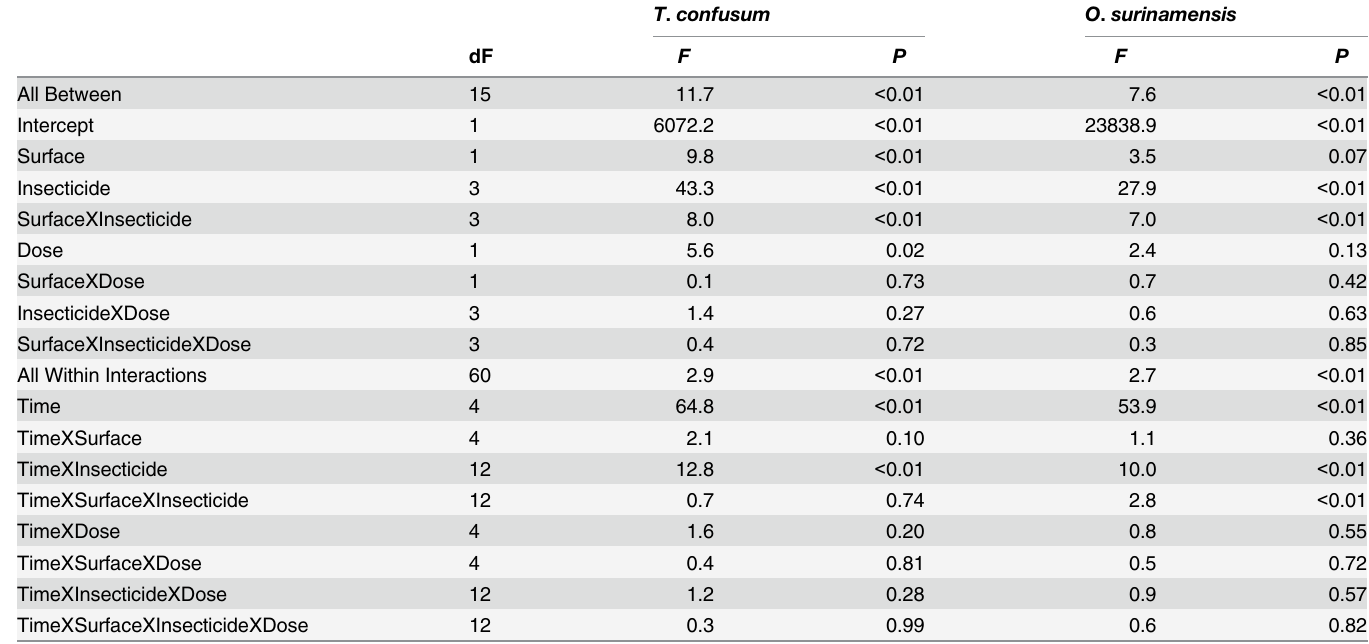
Table 2. Repeated-measures ANOVA for T . confusum and O . surinamensis adult Lethality index (in all cases total error df =